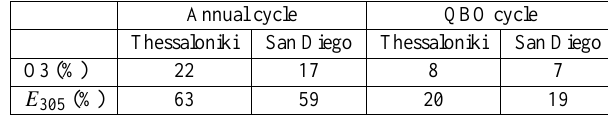
Table 1. Observed peak-to-peak amplitudes for the annual and QBO cycles of ozone and spectral solar irradiance at 305 nm and 63 ◦ SZA at Thessaloniki and San Diego, during the period 1992– 1997 (four QBO cycles)